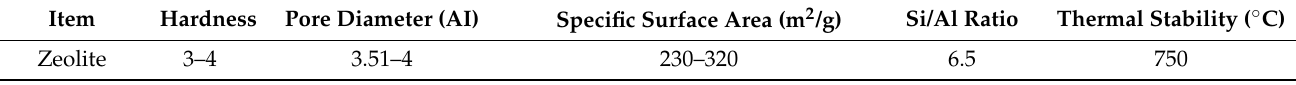
Table A2. Fundamental properties of zeolite.